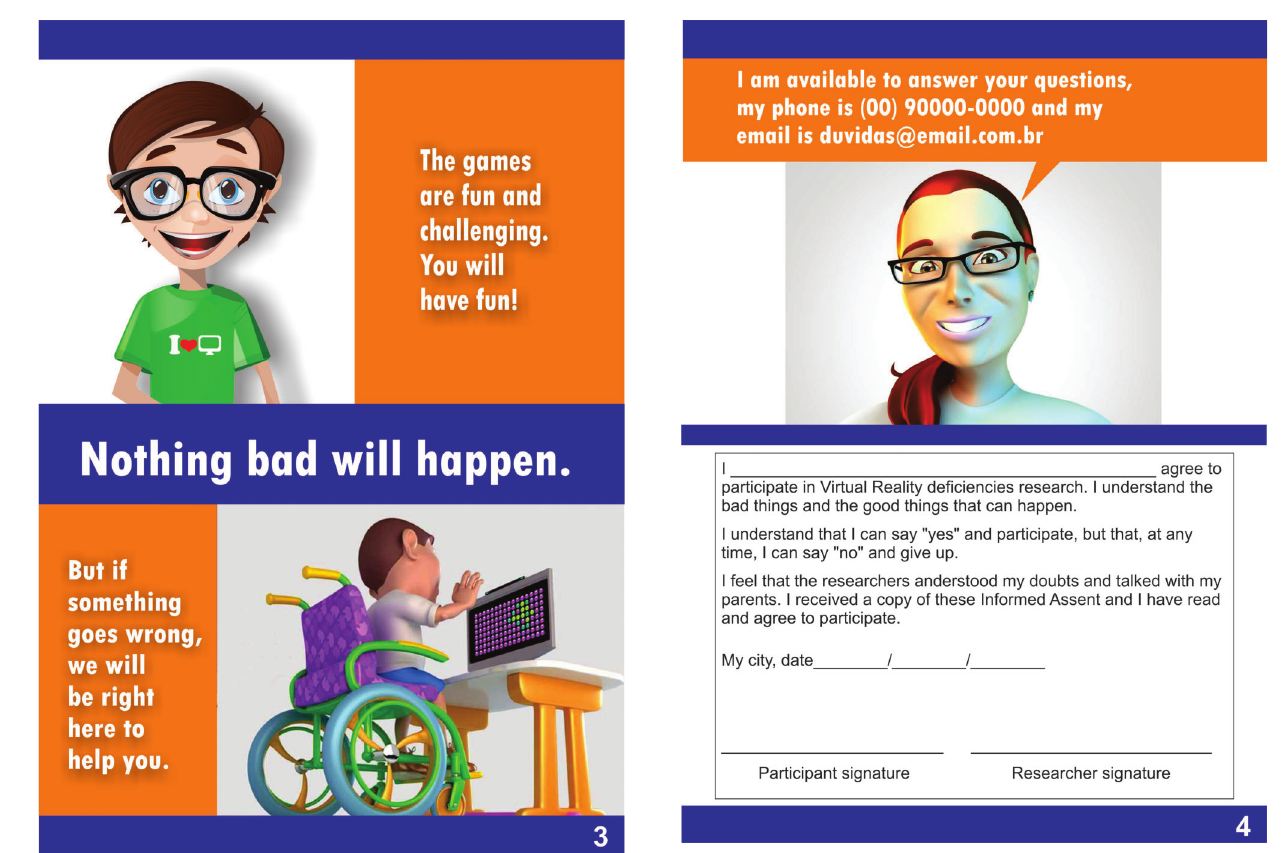
Figure 3C - Model of assent - Part C.